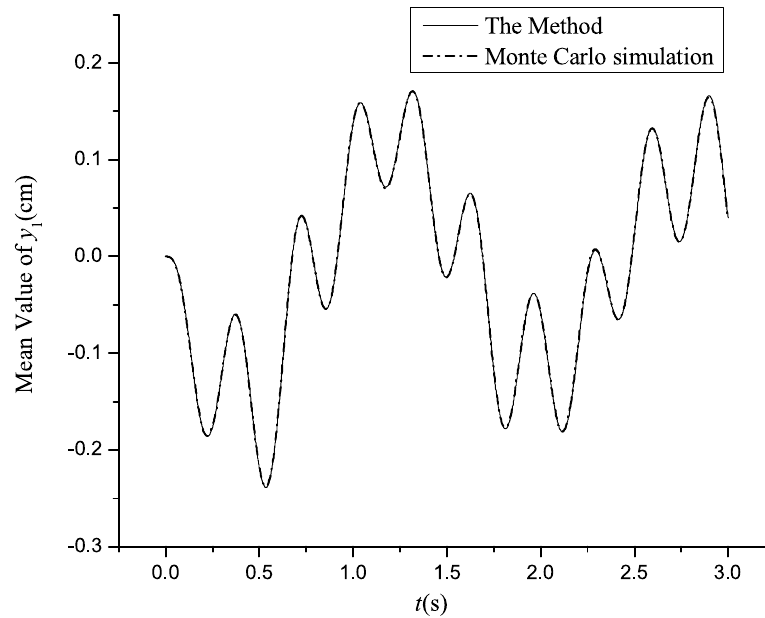
Fig. 2. The mean value curve of the displacement y 1